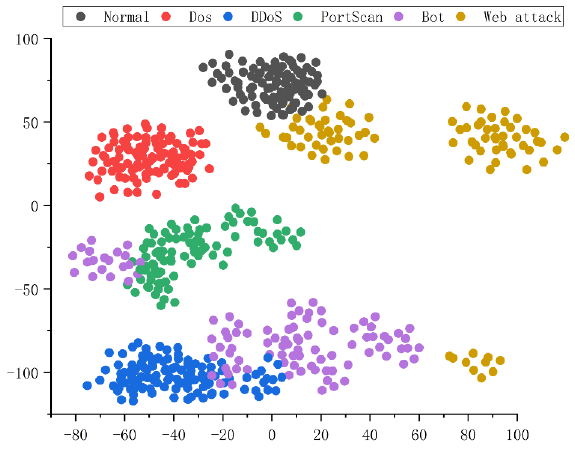
Figure 5. Similarity measure of